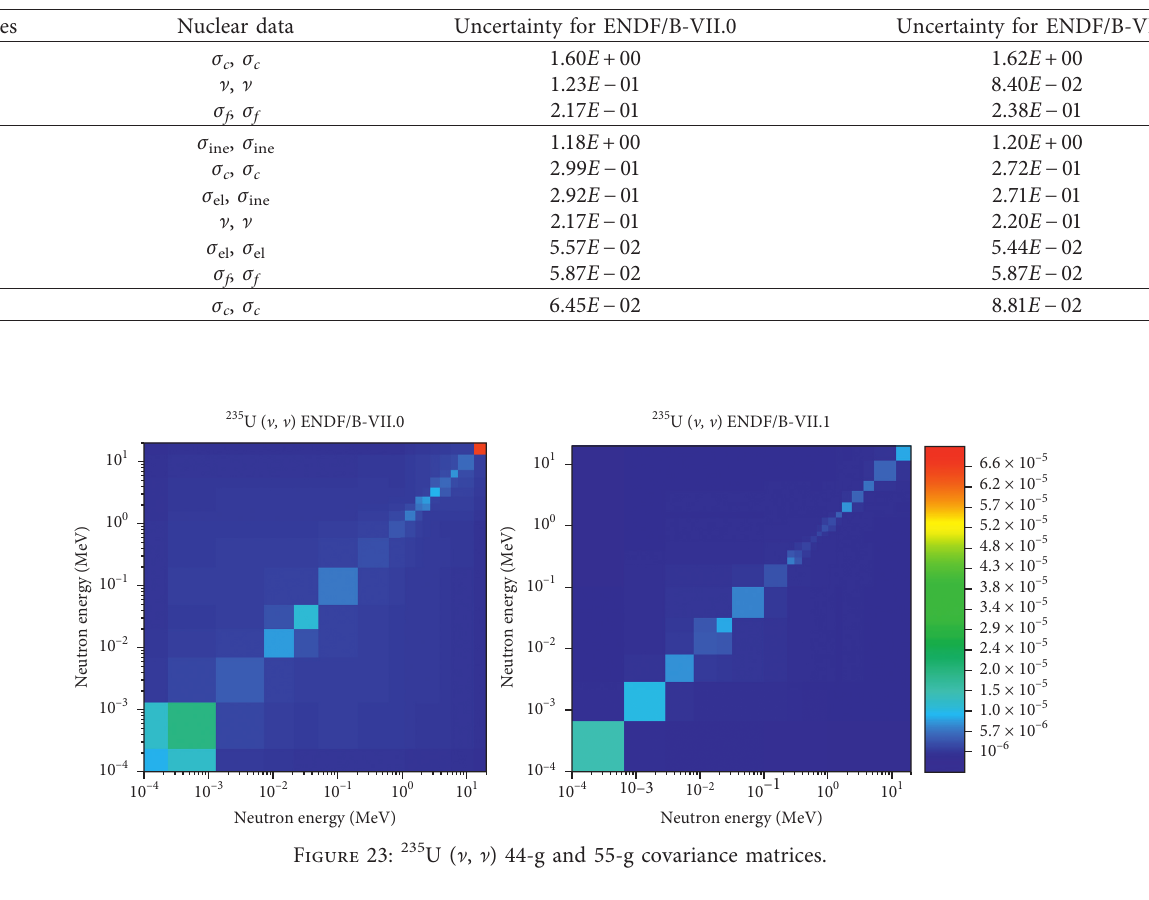
Table 5: Top 10 contributors to k